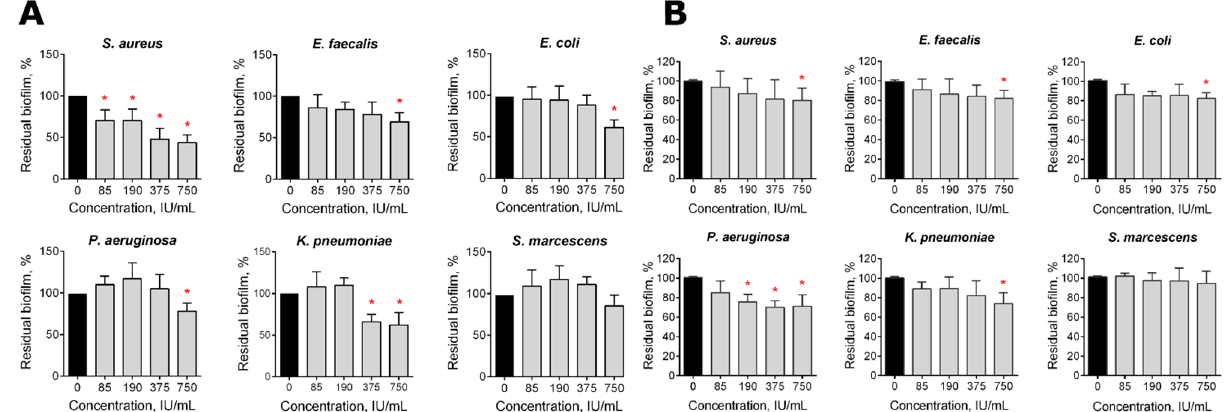
Figure 1. The effect of the Longidaza ® treatment on bacterial biofilms. The 48-h old biofilms were gently washed with BM broth, and a fresh BM broth containing Longidaza ® at concentrations of 85–750 IU/mL was loaded. After either 4 ( A ) or 24 ( B ) hours of treatment, the residual biofilms were quantified by crystal violet staining. The asterisks (*) denote a statistically significant difference of the biofilm in the untreated wells and wells treated with Longidaza ® ( p < 0.05).